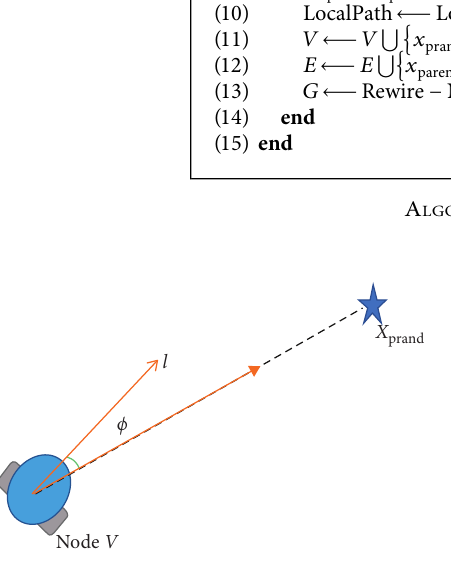
Figure 3: The attitude adjustment of the mobile